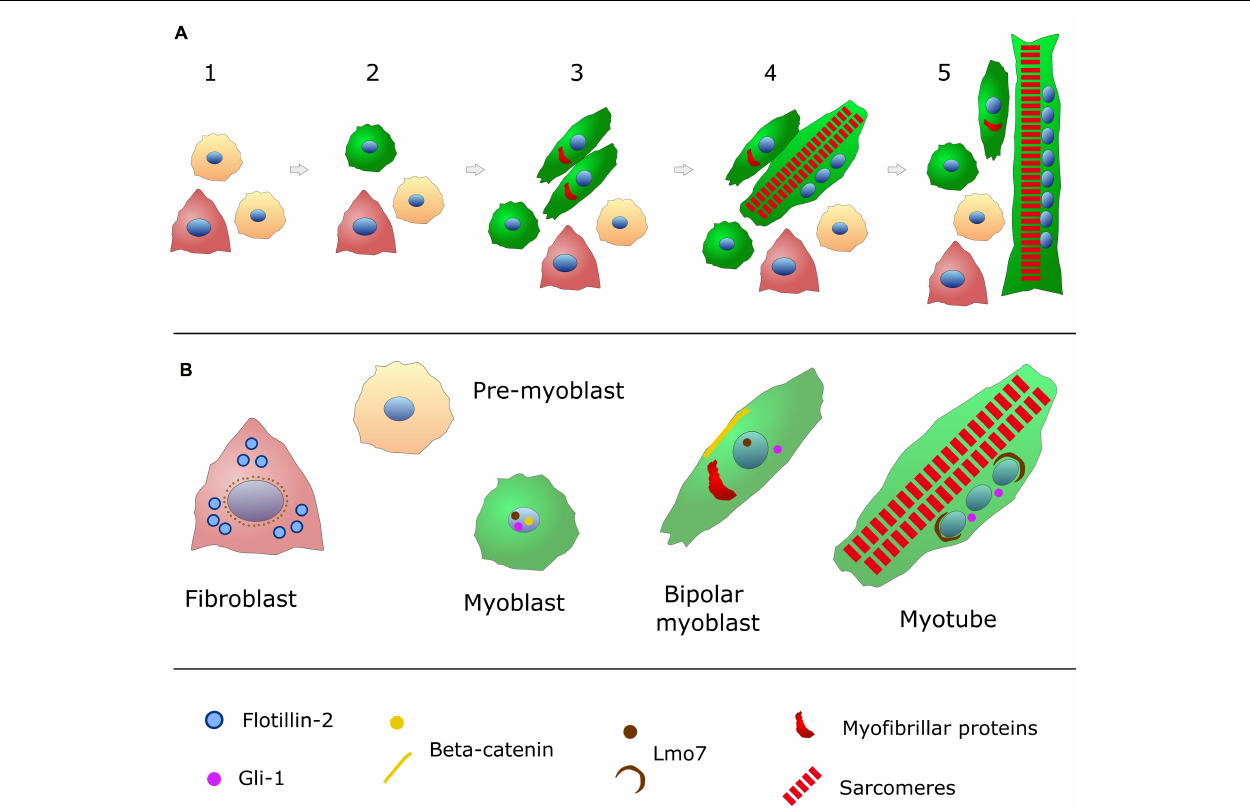
FIGURE 1 | Schematic representation of in vitro chick embryonic skeletal myogenesis. (A) Specific cell phenotypes can be characterized during skeletal muscle development (for more details, see Table 1 ). Presumptive myoblasts (or pre-myoblasts, shown in beige) are mononucleated (nuclei in blue), round shaped and proliferative cells that do not express myofibrillar proteins. When these cells withdraw cell cycle, they begin to express desmin (green in the cytoplasm) and they change to a bipolar shape. These bipolar myoblasts begin to express myofibrillar proteins (red) and they will align with other myoblasts. Cell adhesion and fusion happens between steps 3 and 5. Muscle differentiation culminates with the formation of long and multinucleated myotubes filled (steps 4 and 5) with contractile myofibrils (sarcomeres in red). Pre-myoblasts (beige cells), post-mitotic myoblasts (round green cells), bipolar myoblasts (elongated green cells), and fibroblasts (triangular-shaped and carmine-colored cells) are present in all steps of chick myogenic cultures (steps 1–5). (B) The intracellular distribution of the structural and signaling proteins flotillin-2 (light blue), beta-catenin (yellow), Lmo7 (brown), and myofibrillar proteins (red) are shown for each specific cell phenotype (myoblasts, fibroblasts and myotubes) found in chick myogenic cell cultures.